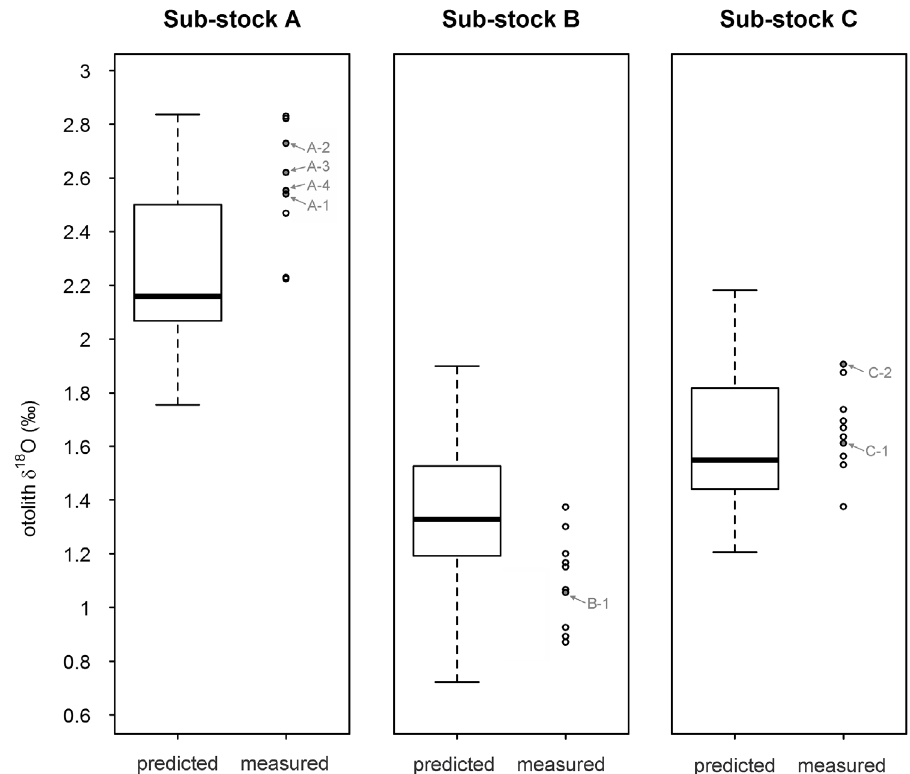
Figure 3. Overall annual otolith d 18 O predictions per sub-stock. Predicted annual d 18 O values (in white), obtained by applying all 3 plausible otolith growth scenarios to the monthly d 18 O derived from the stock-specific temperature and salinity conditions experienced (30,000 simulations), and corresponding measured annual d 18 O values (circles) per sub-stock. In each boxplot, the box includes 50% of the data and the whiskers 100%, with the bold line within the box indicating the median. For each sub-stock, the individual otolith annual d 18 O values of the fish returned with a full annual DST record (c.f. Table 1) are indicated in grey. doi:10.1371/journal.pone.0108539.g003 seven fish returned with full annual DST records (Table 1) confirmed this pattern. Measured annual d 18 O values were slightly, yet consistently, higher (of 0.09 % in A-1, 0.31 % in A-2, measured annual d 18 O was . 0.13 % lower than predicted in B-3. For sub-stock C, the difference between measured and predicted 0.22 % in A-3 and 0.11 % in A-4) than those predicted from